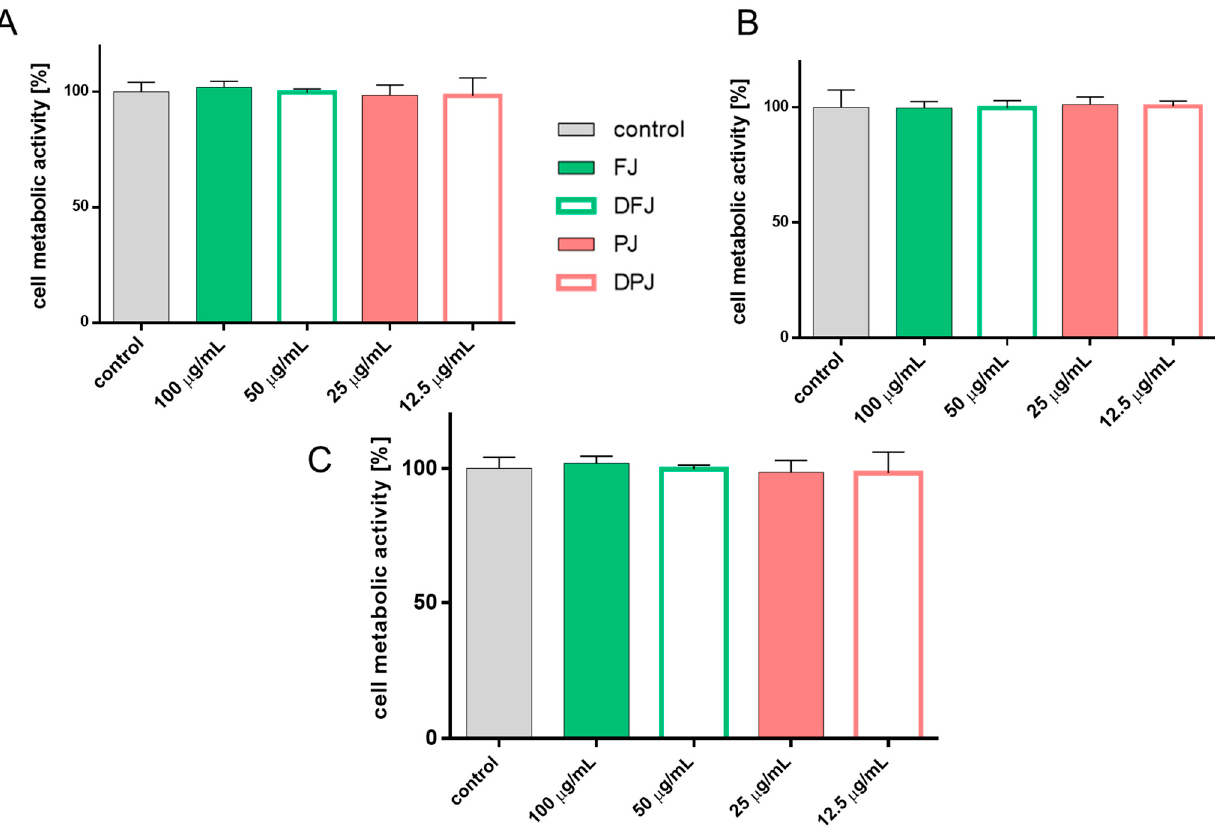
Figure 1. The influence of V. opulus samples on HepG2 ( A ), L6 ( B ), and Caco-2 ( C ) cells’ metabolic activity after 24 h exposure of fresh juice (FJ), purified juice (PJ), and bioavailable fractions after digestion process (DFJ, DPJ) at non-cytotoxic concentration (IC 0 ); control cells were not exposed to any compound except vehicle; values are means ± standard deviations from at least five independent experiments, n ≥ 9; statistical significance was calculated versus control cells (untreated).